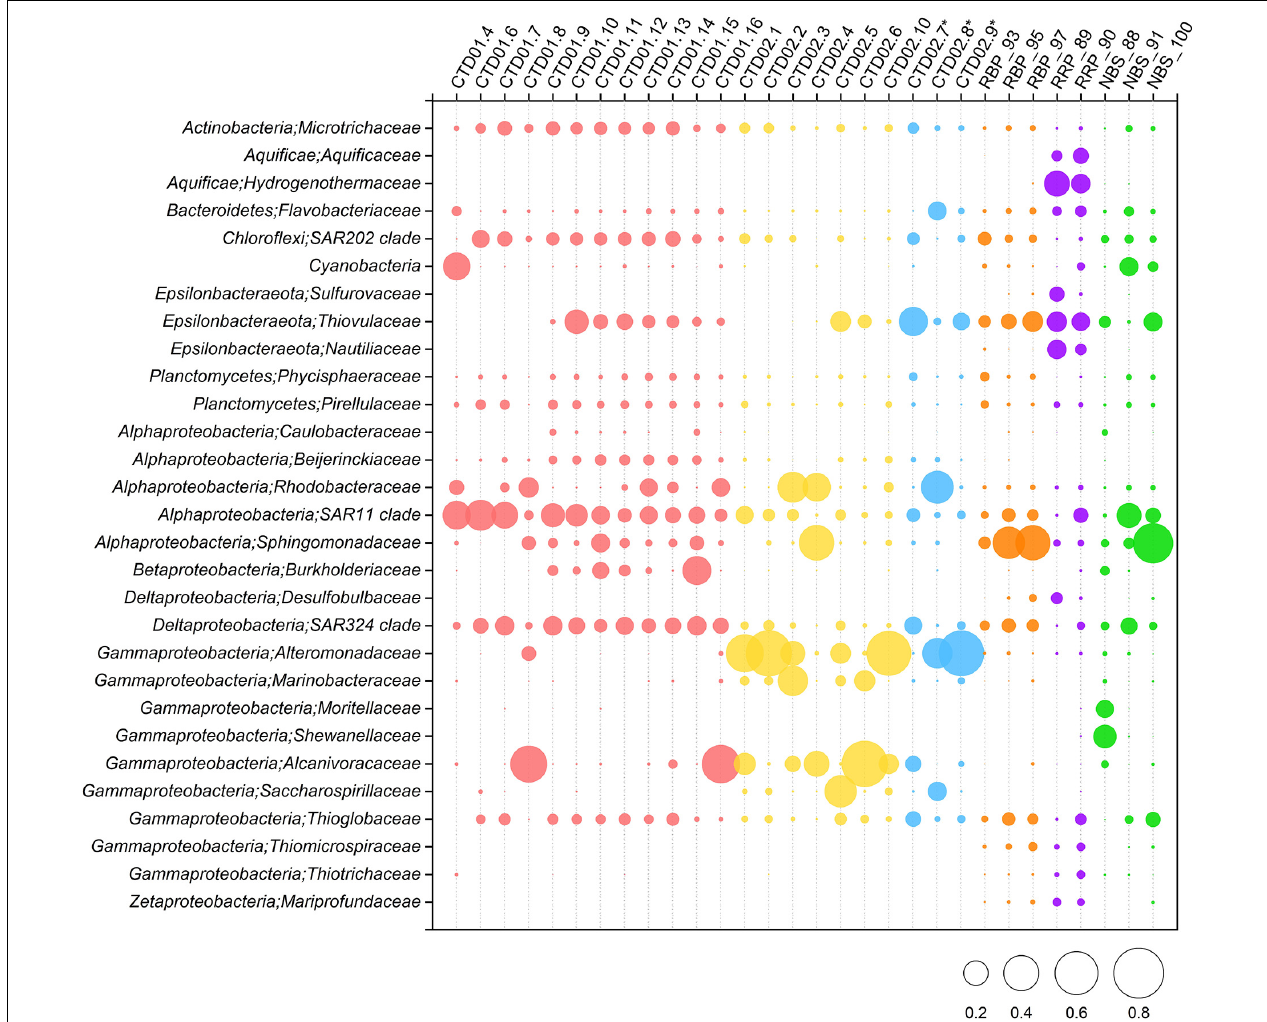
FIGURE 5 | Relative abundances of dominant ( > 1% abundance) bacterial community members in the rising buoyant plumes and ambient near-bottom seawater, the non-buoyant plume and background seawater of the two water columns are at ∼ family level. Some specific vent-associated bacterial groups despite of their low ( < 1%) abundances are shown. ∗ Indicates the three non-buoyant plume samples identified based on CH 4 anomalies.